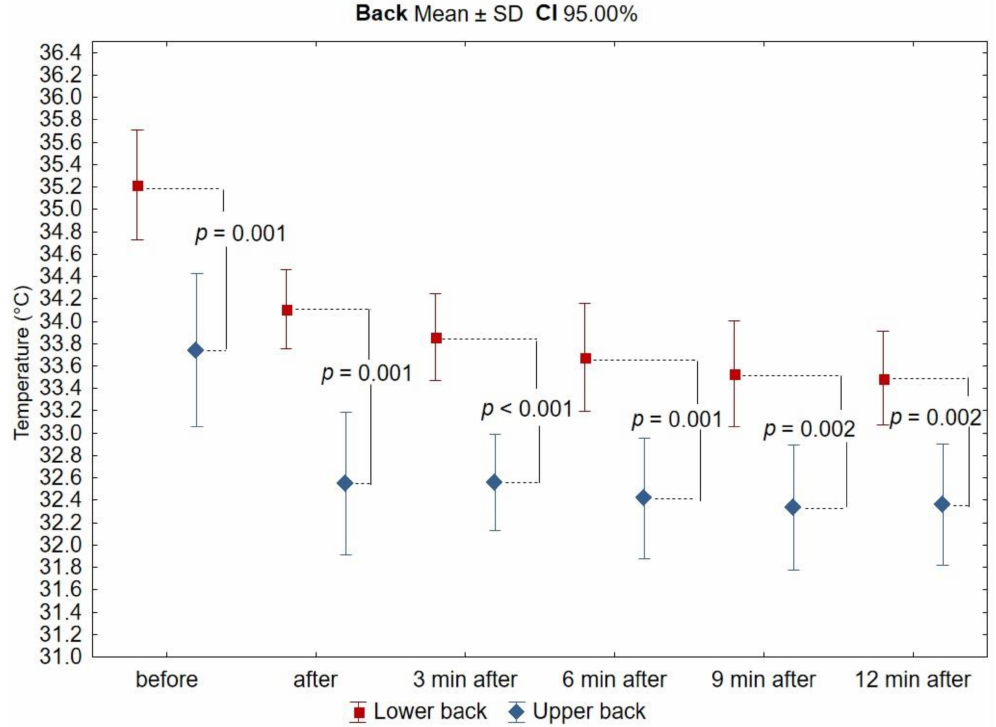
Figure 7. Differences in mean temperature values between the upper and lower back during successive measurement points before and after the exercise test. Legend: the test probability level of the student t -test between the temperature of the anterior and posterior surfaces. Data are expressed as mean with standard